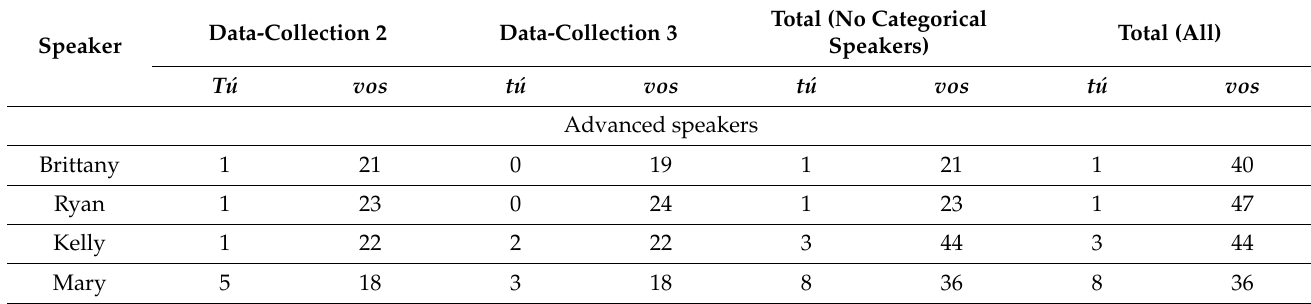
Table 4. Total Tokens by Speaker, Data-collection time, Vos Versus T ú Verb Form Analysis.